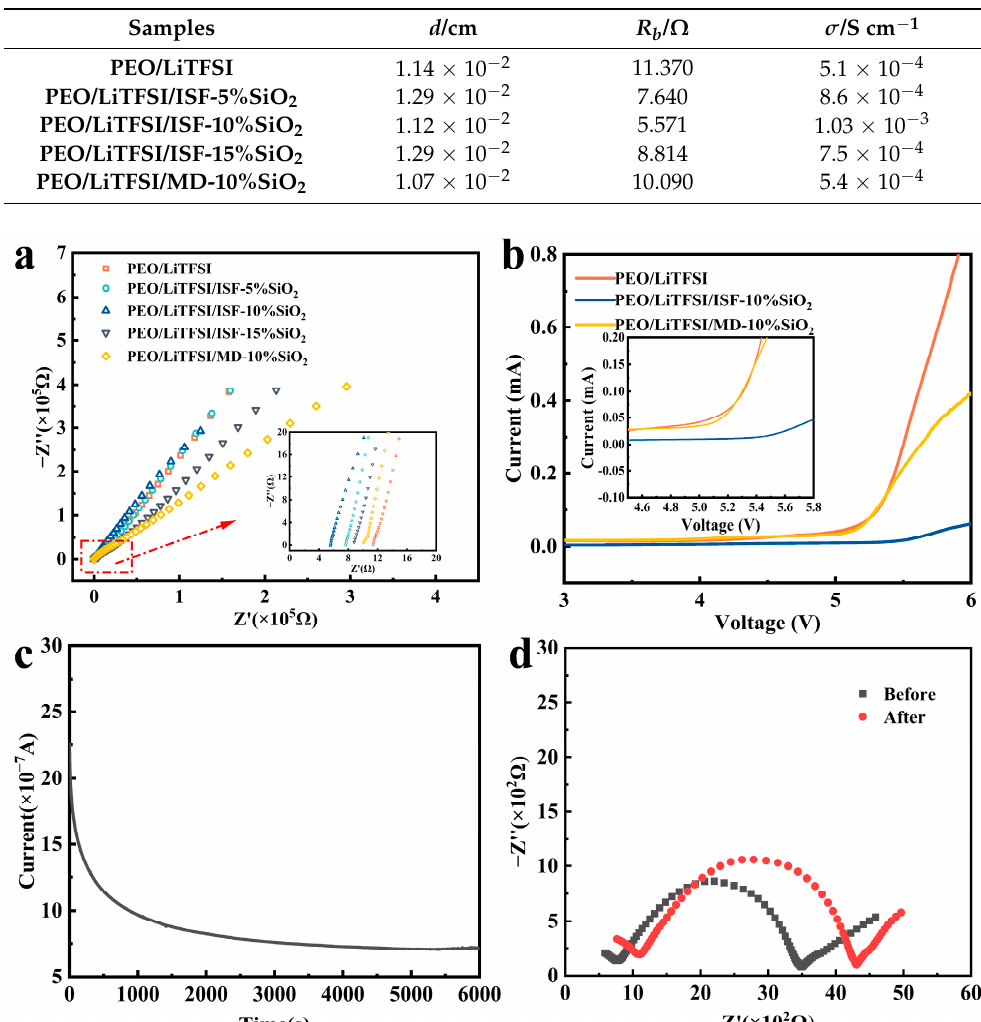
Figure 5. ( a ) Nyquist plots and ( b ) linear sweep voltammetry of the as-spun SPEs at 60 °C, ( c ) DC polarization, and ( d ) EIS curves of PEO/LiTFSI/ISF-10%SiO 2 at 20 °C. Linear sweep voltammetry (LSV) is used to evaluate the electrochemical stability window (Figure 5b). It can be noted that the electrospun SPEs without SiO 2 nanospheres show an obvious oxidation current at 4.8 V versus Li/Li + , and the SPEs with mechanically doped SiO 2 nanospheres show an obvious oxidation current at 5.0 V versus Li/Li + . Inter- estingly, the LSV curve of the as-spun SPEs containing in situ SiO 2 nanospheres shows that the oxidation occurred when versus Li/Li + is up to 5.5 V. This result may be caused by a new chemical bond with the PEO chain during the in situ hydrolysis of TEOS as abovementioned. The new bond may interact with LiTFSI, thus promoting the decompo- sition and stability of the anion. Hence, the wide electrochemical stabilization window allows the as-spun CPEs to be used in a wide range of lithium storage systems, including high-voltage systems. The lithium-ion transfer number ( 𝑡 (cid:3013)(cid:3036) (cid:3126) ) is also an important factor in the performance of SPEs, as low 𝑡 (cid:3013)(cid:3036) (cid:3126) increases the polarisation of the electrode and reduces the perfor- mance of the cell. 𝑡 (cid:3013)(cid:3036) (cid:3126) of Li|PEO/LiTFSI/ISF-10%SiO 2 |Li symmetric cell is determined us- ing the method proposed by Vincent and Evans, as shown in Figure 5c,d. The correspond- ing value is 0.282 at 20 °C (Table 4), which is higher than that of PEO/LiTFSI SPEs (0.141, 80 °C) without SiO 2 nanospheres [43]. Corresponding to the results of EIS, this phenome- non can be a tt ributed to in-situ-generated SiO 2 , which act as the physical crosslinking cen- ter, changing the structural state of the polymer chain segment, and providing more paths for Li + transmission. In addition, the CPE prepared by the electrostatic spinning process has a unique 3D network structure, which can provide fast 1D channels of ion transmis- sion for the conduction of lithium ions [28–31]. At the same time, due to the equilibrium relationship of the Lewis acid–base reaction, SiO 2 and TFSI - groups compete in binding